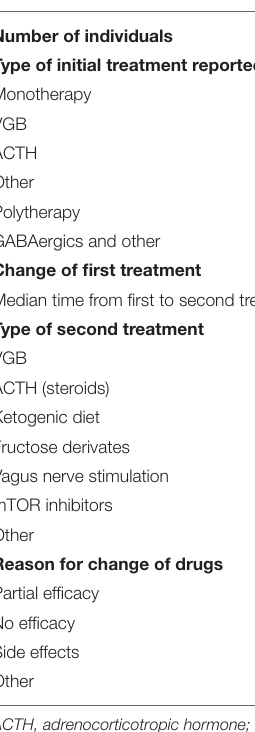
TABLE 3 | Initial and change in the treatment and reason for change in the epilepsy substudy. Number of